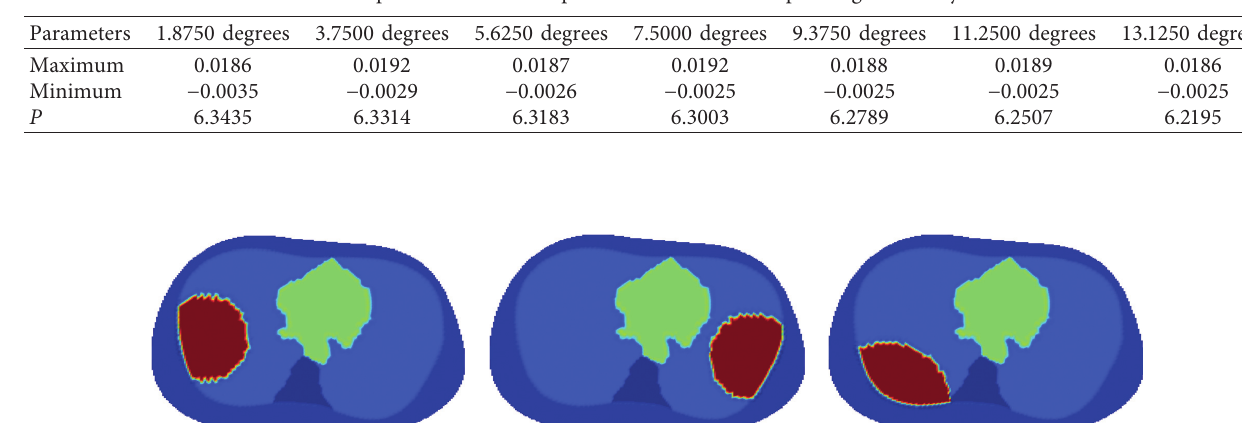
Figure 3: Schematic diagram of sensitivity distribution. Table 1: Comparison of different parameters of the corresponding sensitivity matrices.